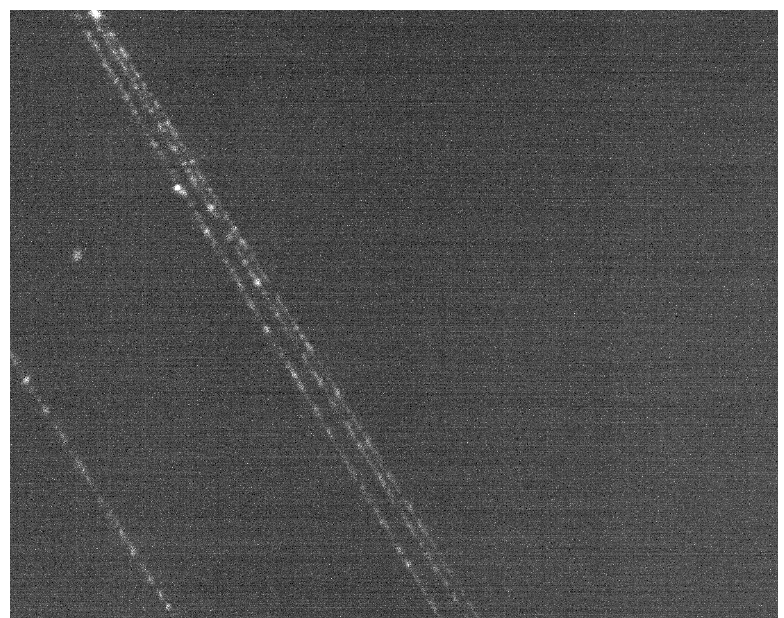
Figure 2. Detail of an image collected with the sCMOS sensor of several tracks in cosmic rays. The effective ranges of electron and He-nuclei recoils were simulated, respectively, with the G EANT 4 [47] and Stopping and Range of Ions in Matter (S RIM ) software (Visit the http://www.srim.org/ site for more information, accessed on 18 November 2021). The average 3D ranges (i.e., the distance between the production and absorption point) as a function of the particle kinetic energy are shown in Figure 3: